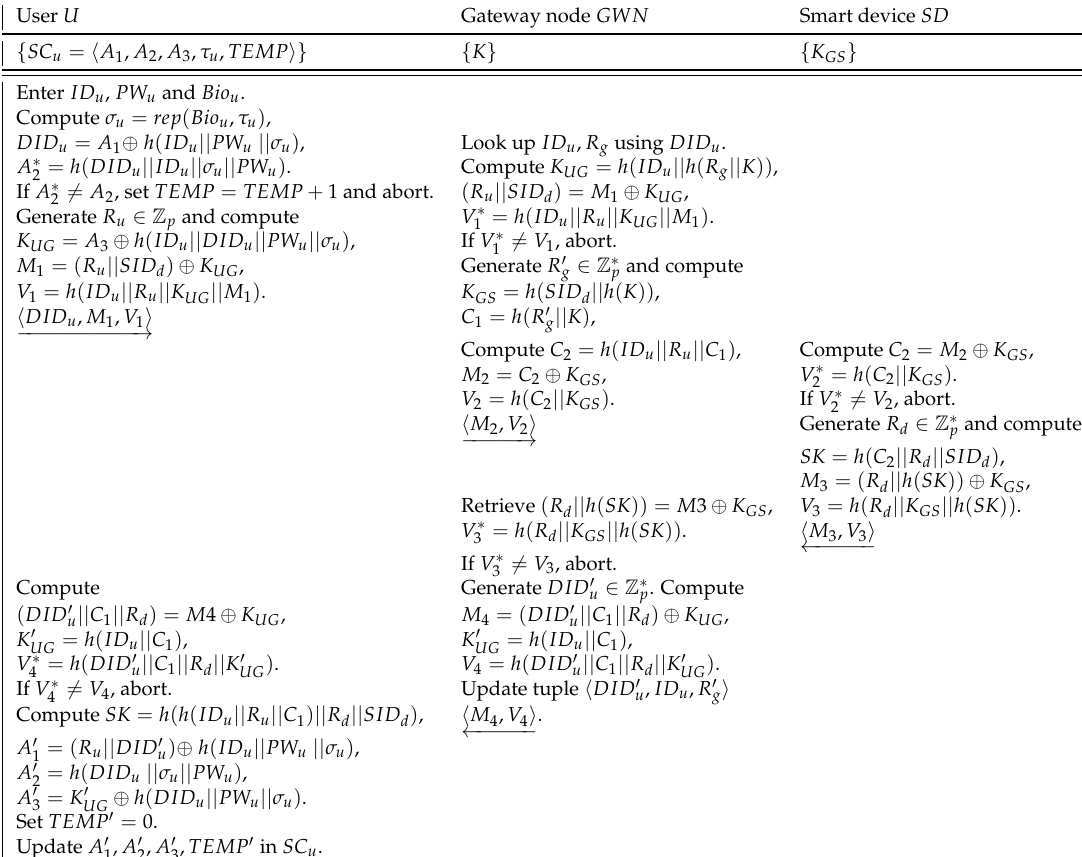
Figure 3. Summary of login and authentication